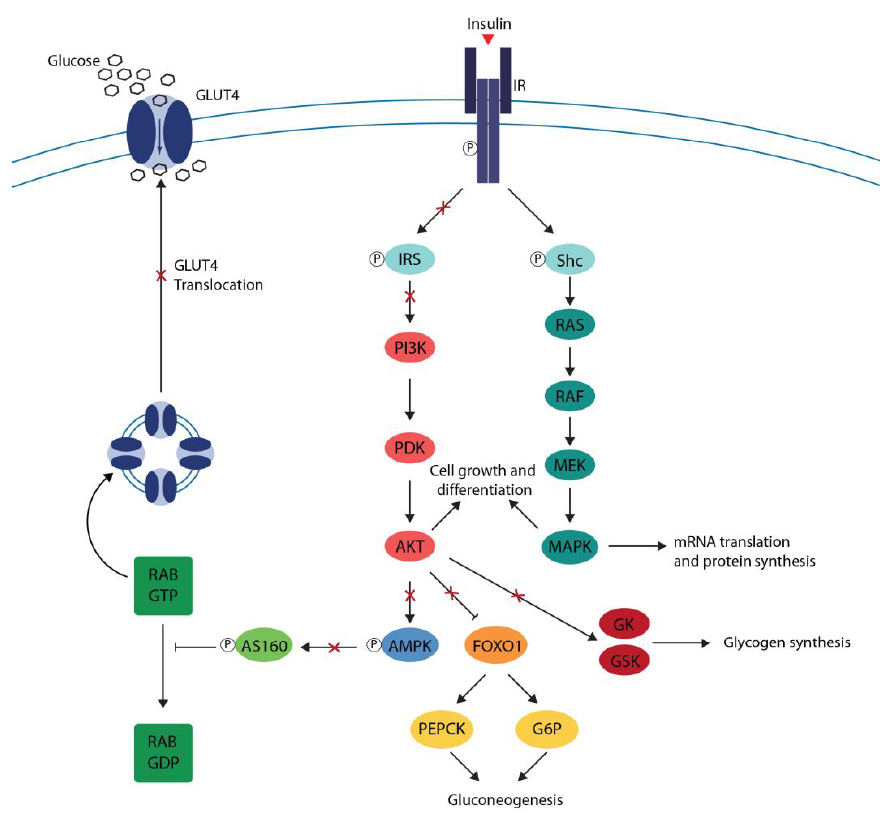
Figure 2. Impaired Insulin signaling. Insulin resistance impairs the activation of PI3K / Akt of the skeletal muscle and adipose tissue leading to a decreased GLUT4 expression and translocation, resulting in impaired glucose uptake. Deficits in hepatic insulin signaling release FOXO1 back to the nucleus to promote the expression of PEPCK and G6P genes promoting gluconeogenesis and decrease GK and GSK activation suppressing glycogen synthesis. Arrow with red X: impaired stimulation, T bar with red X: impaired inhibition